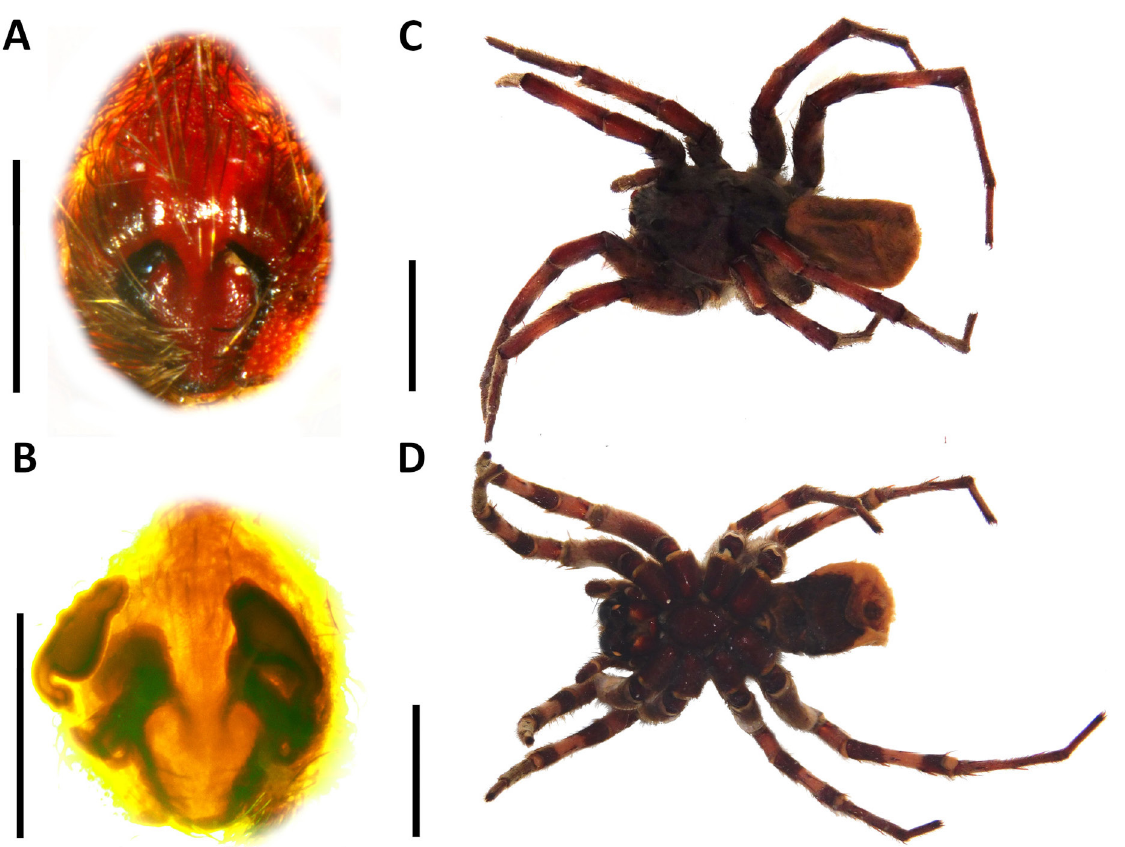
Fig. 18. Lycosa piochardi Simon, 1876, paratype, ♀ (MNHN 1266, vial 2076). A . Epigyne, ventral view. B . Epigyne, dorsal view. C . Habitus, dorsal view. D . Habitus, ventral view. Scale bars A–B = 0.5 mm; C–D = 10 mm. Photos by I. Armiach